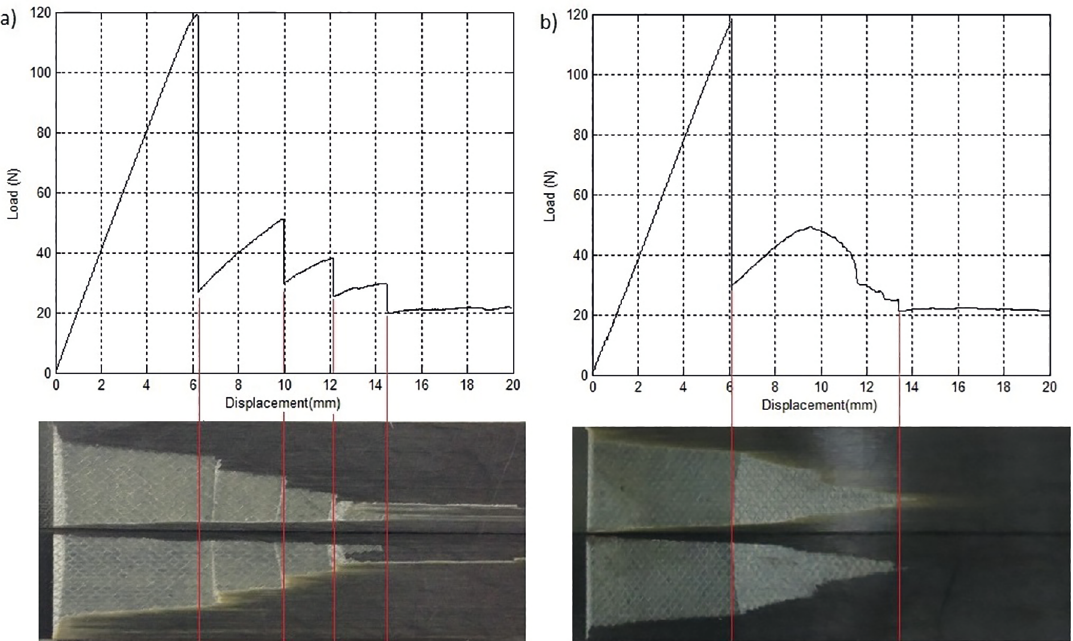
Figure 3. Load versus Crack Length curves correlated to the tested specimens fracture surfaces. a) co-bonded; b) secondary bonding